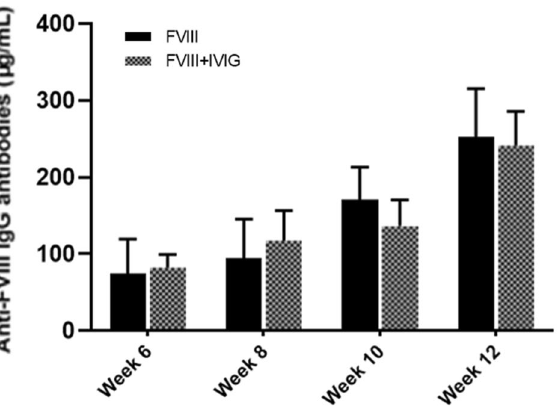
Figure 6. Effect of FVIII and IVIG co-injection on anti-FVIII antibody development in previously immunized hemophilia A mice. First, mice in both groups were immunized with weekly FVIII injections for 4 weeks. All mice had detectable anti-FVIII antibodies at this point. Then, mice in the original FVIII alone group continued to be injected weekly with FVIII for an additional 8 weeks while mice in the other group were treated with co-injection of FVIII with IVIG weekly. Plasma samples were collected and anti-FVIII antibody levels analysed as described in Fig. 2. Data are presented as mean and error bars represent the SEM. The differences between two groups are not significant (n =